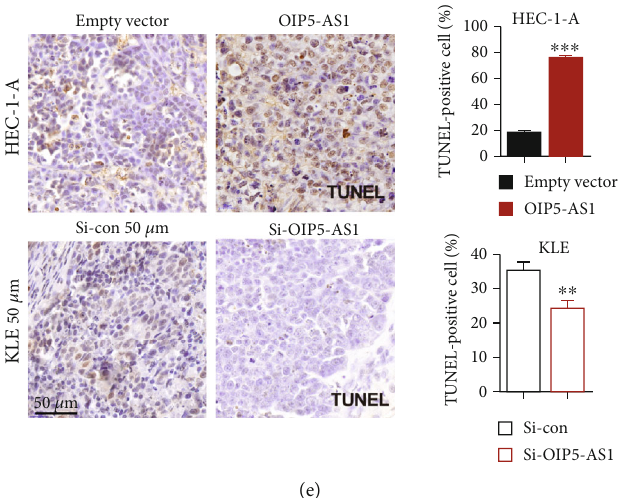
Figure 4: Upregulation of OIP5-AS1 could suppress the growth of endometrial tumors in vivo. (a) Representative images of EC xenografts formed by HEC-1-A and KLE cells while altering the OIP5-AS1 level. (b) Tumor growth cure represented the tumor ’ s volume measured at 7 days, 14 days, 21 days, and 28 days. N = 6 each group. (c, d) Immunohistochemical staining for Ki-67 of tumor nodules and quantitative analysis. ∗∗ P < 0 : 01 and ∗ P < 0 : 05 . (e) Immunohistochemical staining for TUNEL of tumor nodules and quantitative analysis. ∗∗∗ P < 0 : 001 and ∗∗ P < 0 : 01